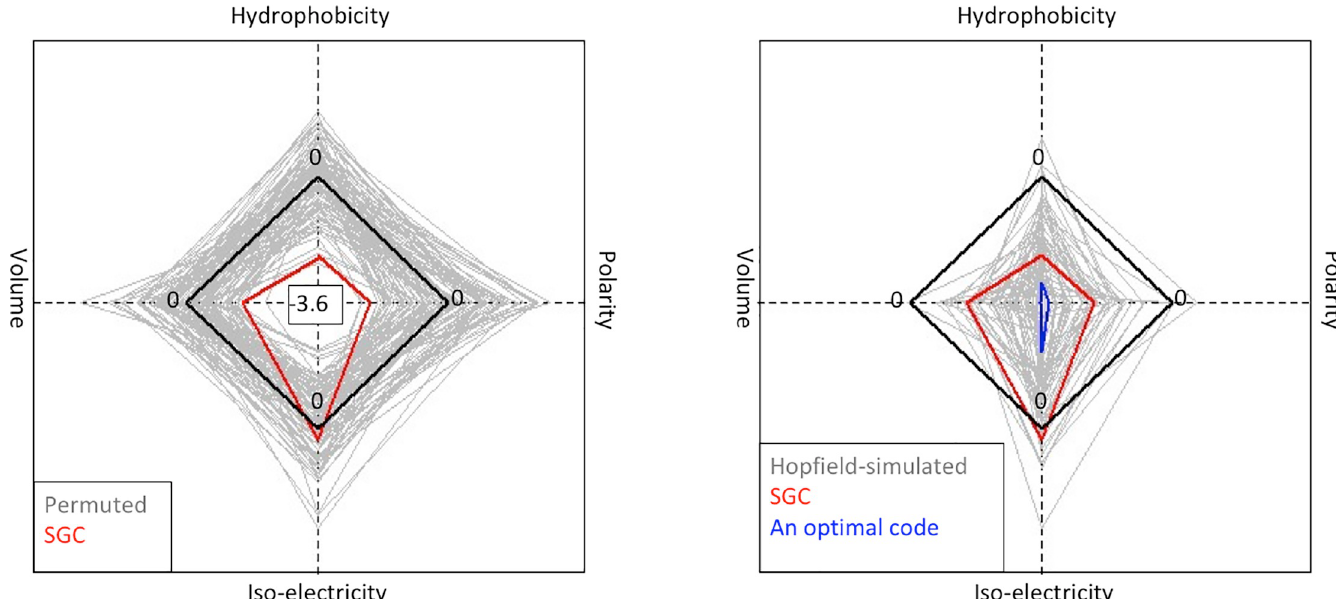
Fig 5. Hopfield network yielded genetic codes more optimal than SGC. ( Left Panel ) In this alternative display of error rates of genetic codes, each code is represented by a quadrilateral with vertices defined by the four errors. The black diamond represents the average errors of the permuted codes (n = 100). Note that the minimum error (-3.6 standard deviation from the mean) is placed at the center for all four parameters so that the smaller a quadrilateral condenses towards the center the more optimal a code is. ( Right Panel ) Gray quadrilaterals represent Hopfield-simulated codes (n = 52) optimized for polarity and volume (the same output used for Fig 4, 2 nd row). The simulated codes have generally less errors than randomized codes. Many are more optimal than SGC, one of which is highlighted in blue and its coding pattern is shown with a codon wheel (Fig